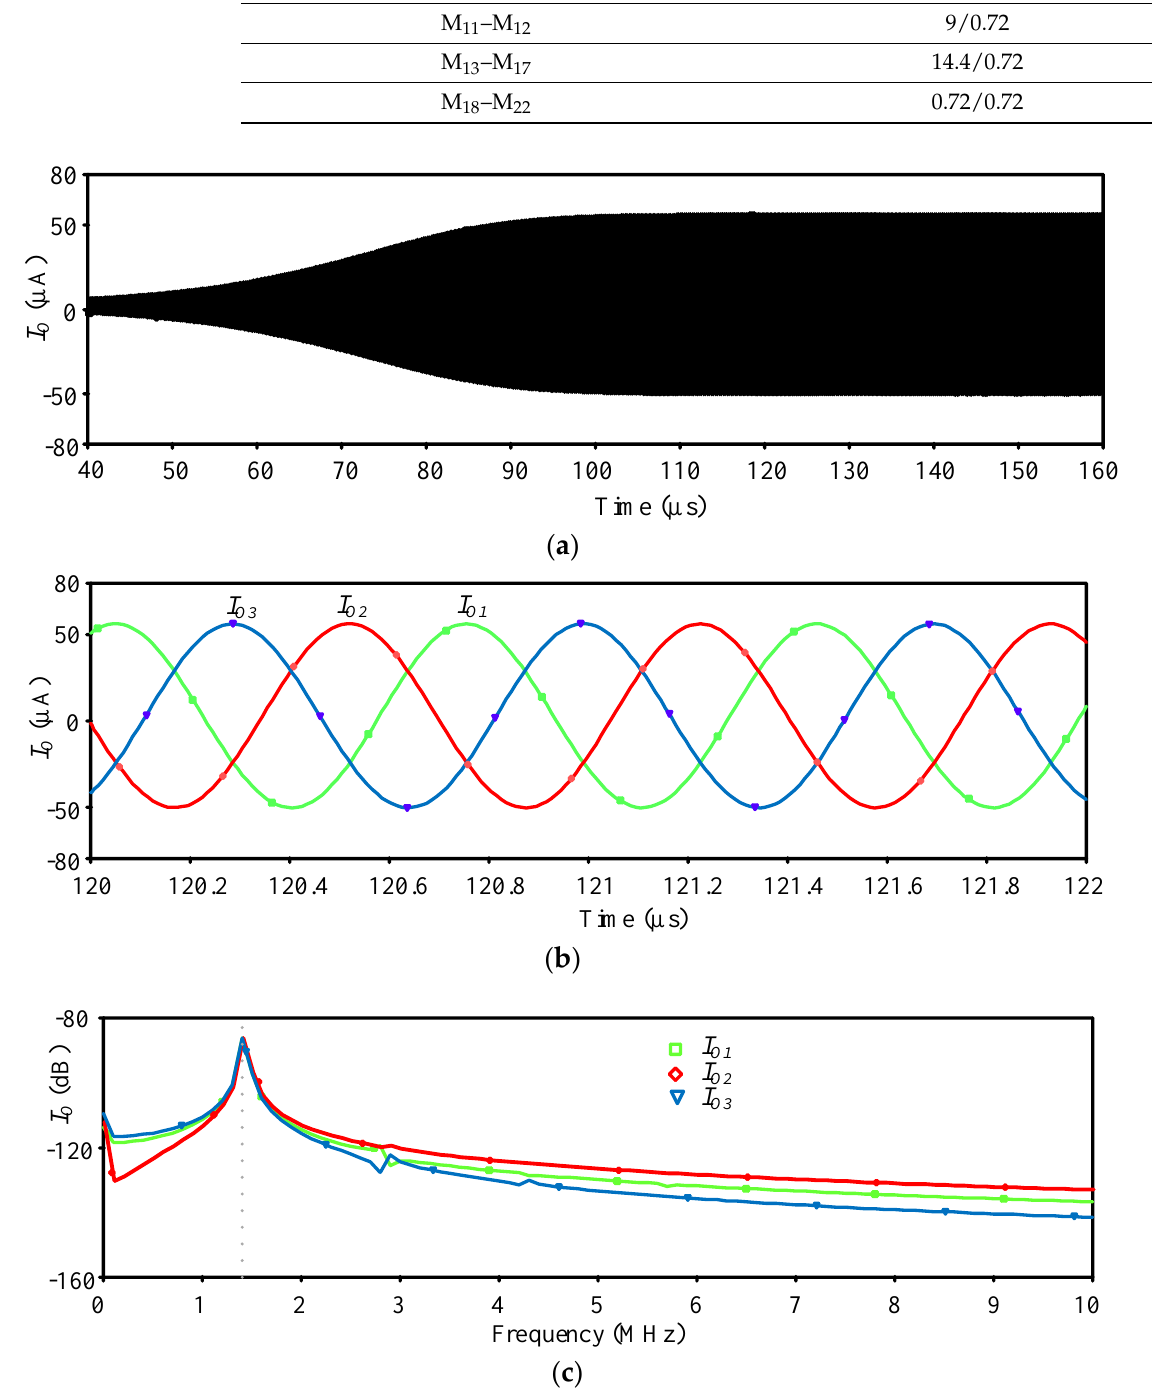
Figure 7. Simulation of the current-output waveform ( a ) initial-state ( b ) steady-state ( c ) output spectrum.